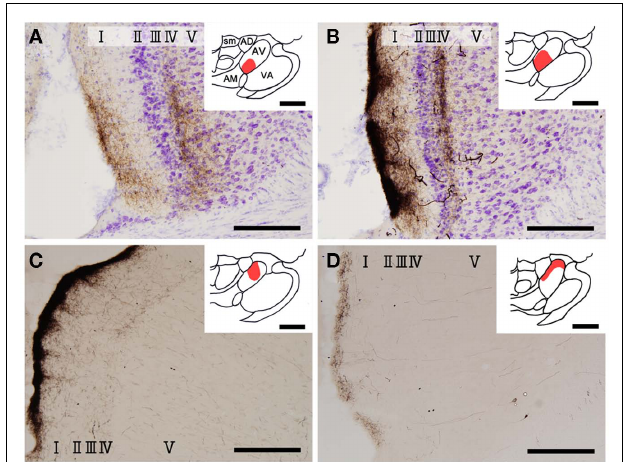
FIGURE 1 | Biotinylated dextran-amine injection sites (insets) and examples of labeled axons in the GRS. Schematic drawing of BDA injection sites in the AV thalamus (in red in insets). (A–D) Correspond to rat 1, rat 2, rat 3, and rat 4, respectively.Tissues were counterstained for Nissl in (A,B) . Abbreviations: I, layer I; II, layer II; III, layer III; IV, layer IV;V, layerV; VI, layerVI; AD, anterodorsal thalamic nucleus; AM, anteromedial thalamic nucleus; AV, anteroventral thalamic nucleus; LD, laterodorsal thalamic nucleus; MD, mediodorsal thalamic nucleus; Rt, reticular thalamic nucleus; sm, stria medullaris of the thalamus. Scale bar, 200 μ m, 1mm